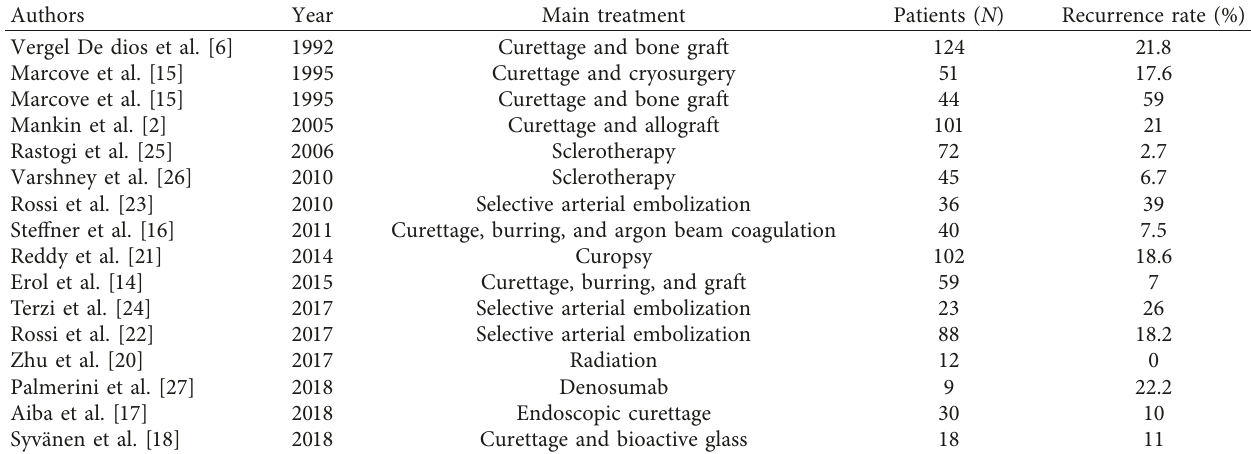
Table 2: ABC treatment modalities and their recurrence rates reported by different